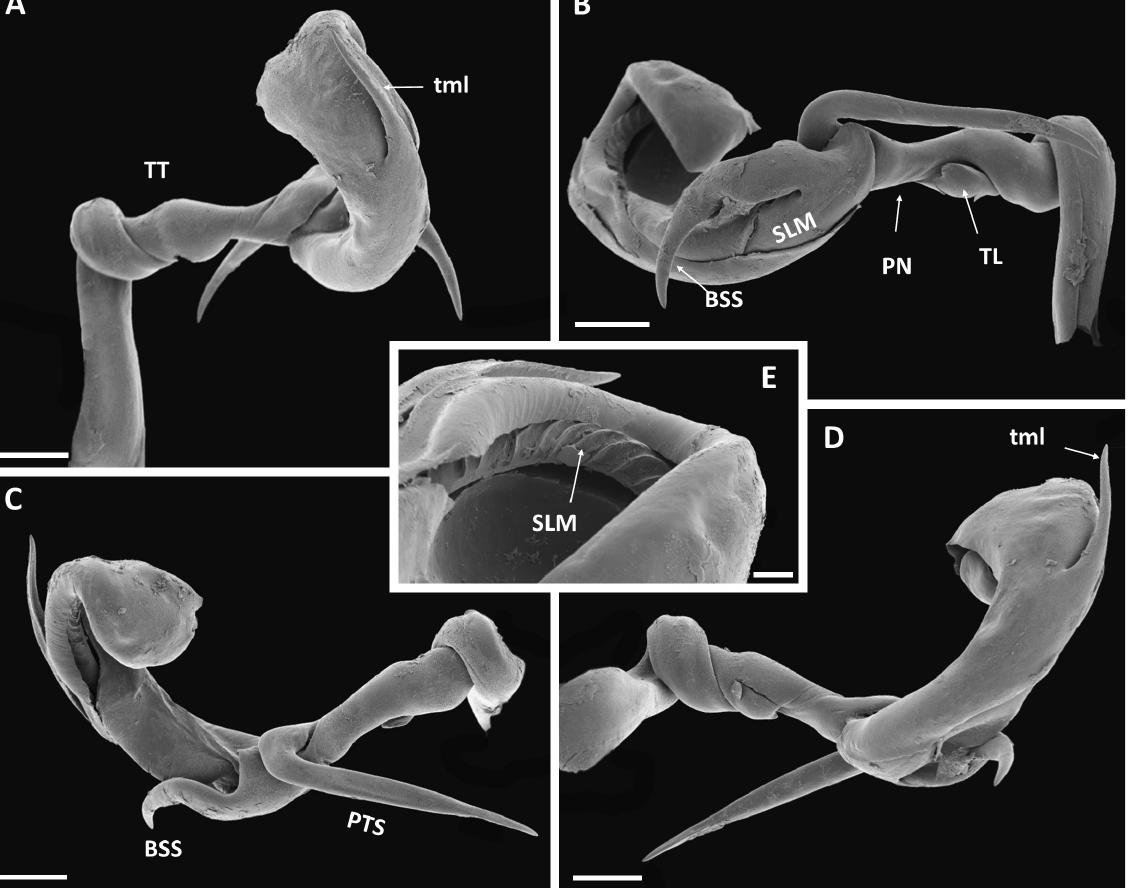
Fig. 20. Calyptomastix xystopygoides sp. nov., holotype, ♂ (NHMD 621718), left gonopod telopodite. A . anterior-mesal view. B . Posterior view. C . Ventral view. D . Dorsal view. E . Detail of telomere and ridged solenomere. Abbreviations: BSS = basal solenomeral spine; PN = post-torsal narrowing; SLM = solenomere; TL = torsotope lobe; tml = telomeral spinelike lobe; TT = torsotope; PTS = post-torsal spine. Scale bars: A–D = 0.2 mm; E = 0.05